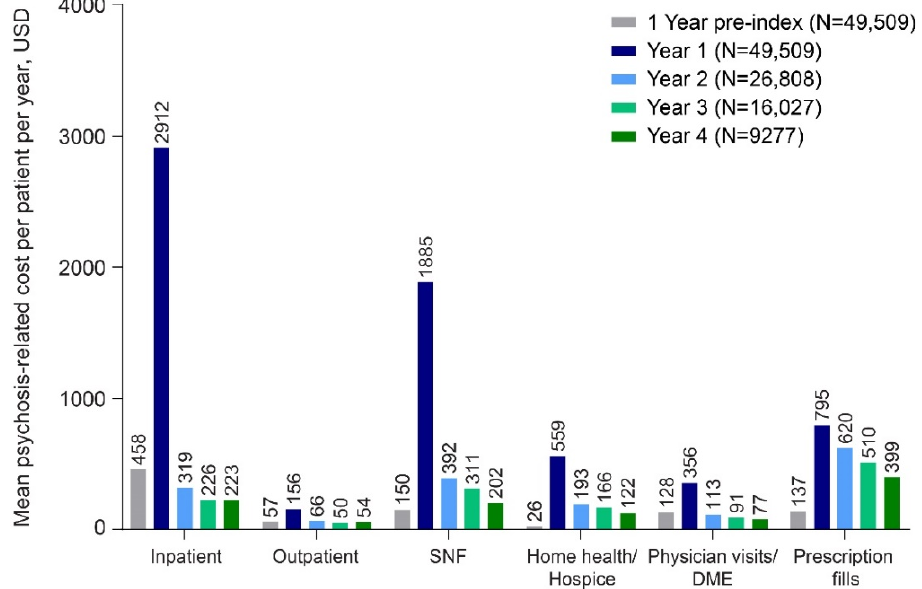
Figure 3. Annualized unweighted psychosis-related costs per patient per year by type of Medicare Set- ting in 2015 USD. LTC and Medicare costs may not sum to total row costs due to rounding. Abbreviations: DME = durable medical equipment; LTC = long-term care; SNF = skilled nursing